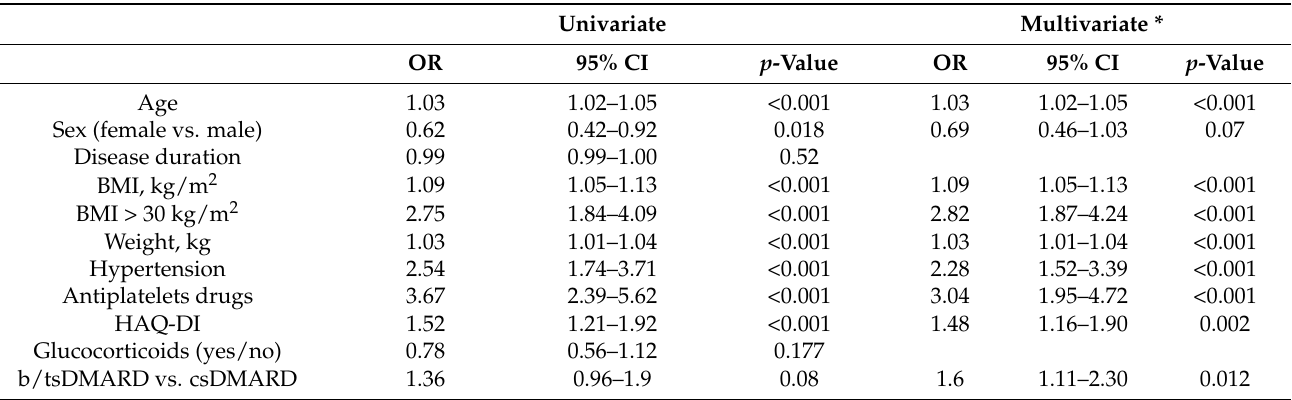
Table 2. Logistic regression